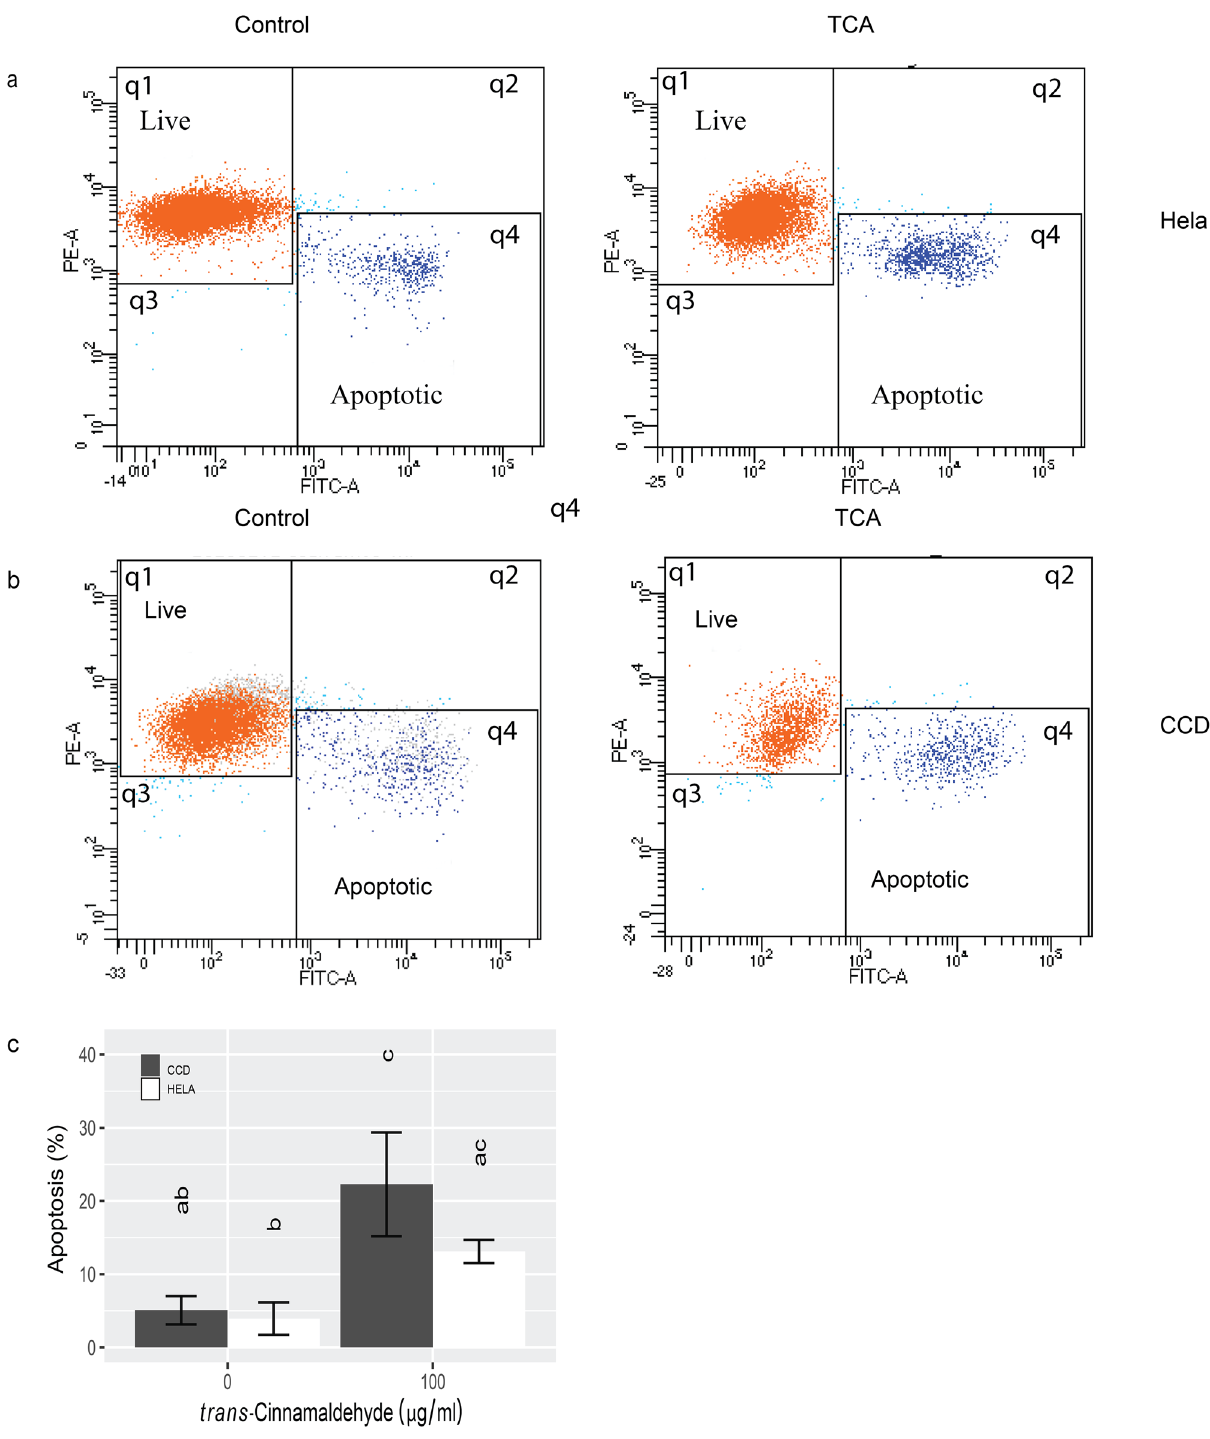
Figure 3. Flow cytometry analysis for apoptosis in HeLa ( a ) and CCD cells ( b ) after TCA (0 and 100 µg/ml) treatment for 4 h. In each scatterplot, live cells (red dots in q1) were stained positive for Mito tracker (red) and negative for Annexin V which indicated positive mitochondrial activity and apoptotic cells, respectively. Apoptotic cells (dark blue dots in q4) were Annexin V and Mito tracker positive. ( c ) The mean percentages of apoptotic HeLa and CCD cells before and after TCA treatment. While both cell types responded to TCA and no significant difference was found between the cell type, with CCD cells appearing to have an accelerated